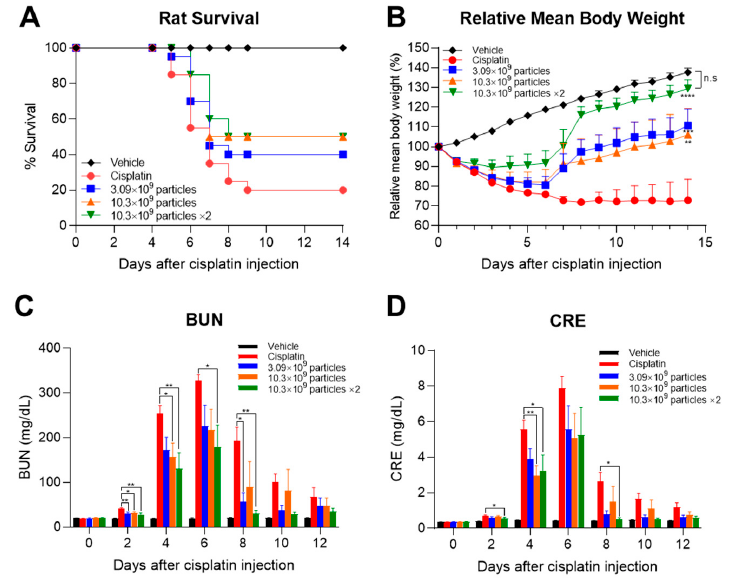
Figure 6. Therapeutic effects of ASC-exosomes on cisplatin-induced AKI in rats. ( A ) Number of surviving animals over time. ( B ) Changes in relative body weight over time. The levels of ( C ) blood urea nitrogen (BUN) and ( D ) serum creatinine over time. Results are presented as mean ± SEM. n = 10 for each group. * p < 0.05, ** p < 0.01 and *** p < 0.001 vs. cisplatin control group. Vehicle: normal rat injected with vehicle control; cisplatin: cisplatin-challenged rat injected with vehicle control; other: cisplatin-challenged rat injected with indicated dose per head of ASC-exosomes; x2: two times administration of ASC-exosomes on day 0 and